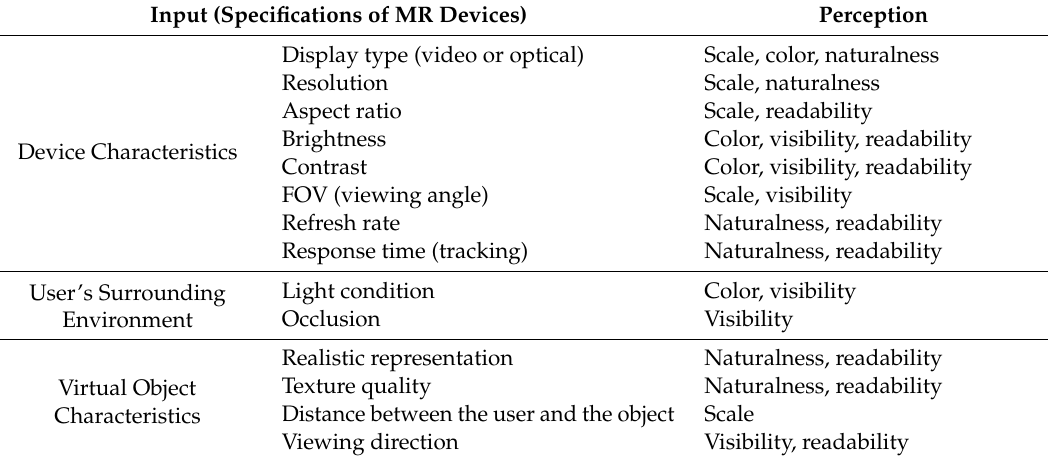
Table 1. Our newly configured perception issues with the work of Kruij ff et al. [6]. We classified elements of the users’ perceptions, examples of users’ perceptions (output), and visual elements to a ff ect users’ perceptions (input). In our paper, we presented a way to evaluate user perception (with display type as an independent variable and scale and color perception as dependent variables. The remaining parameters should be used as control variables in the